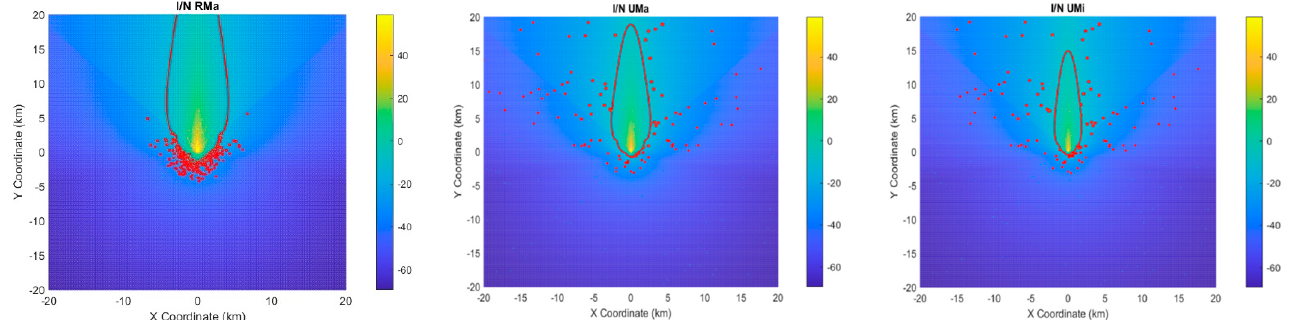
Figure 13. The elevation plane.